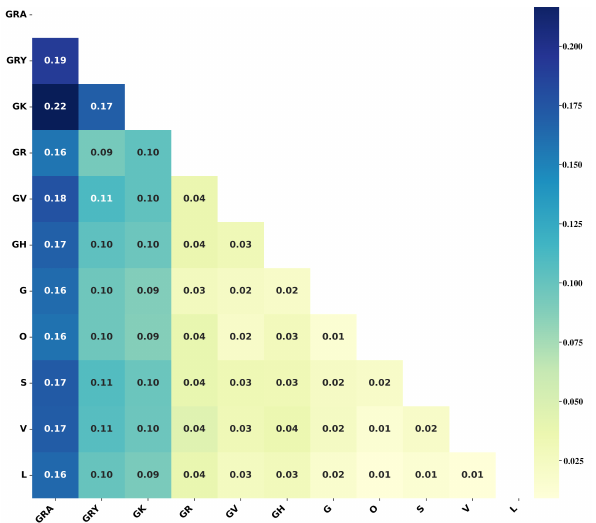
Figure 10. The difference matrix D of the GISAID clades. Each element in the matrix represents the difference between the corresponding two GISAID clades, and the dark color represents a larger difference.